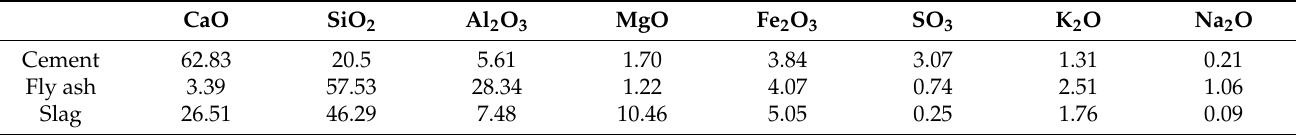
Table 1. Chemical composition of raw materials.